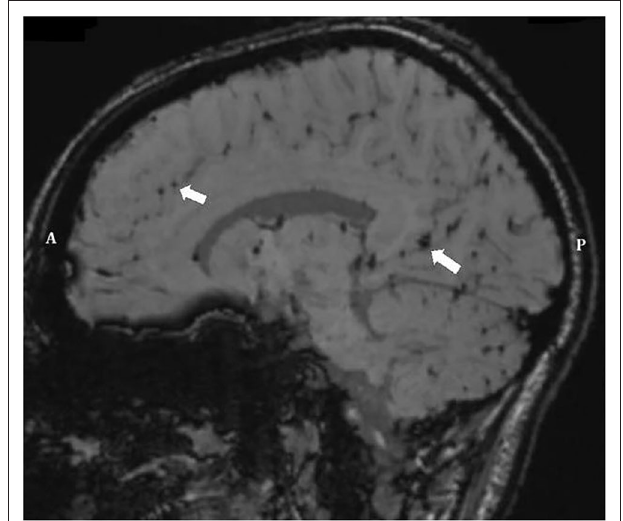
FIGURE 13 | Sagittal SWI image of Player 3 (1) demonstrating multiple small areas of signal loss in the base of the sulci. Paramagnetic compounds from hemorrhages distort the magnetic field resulting in the signal loss. Arrows point to areas of micro-hemorrhage, hemosiderin, and axonal shearing/injury. Anterior (A) Posterior